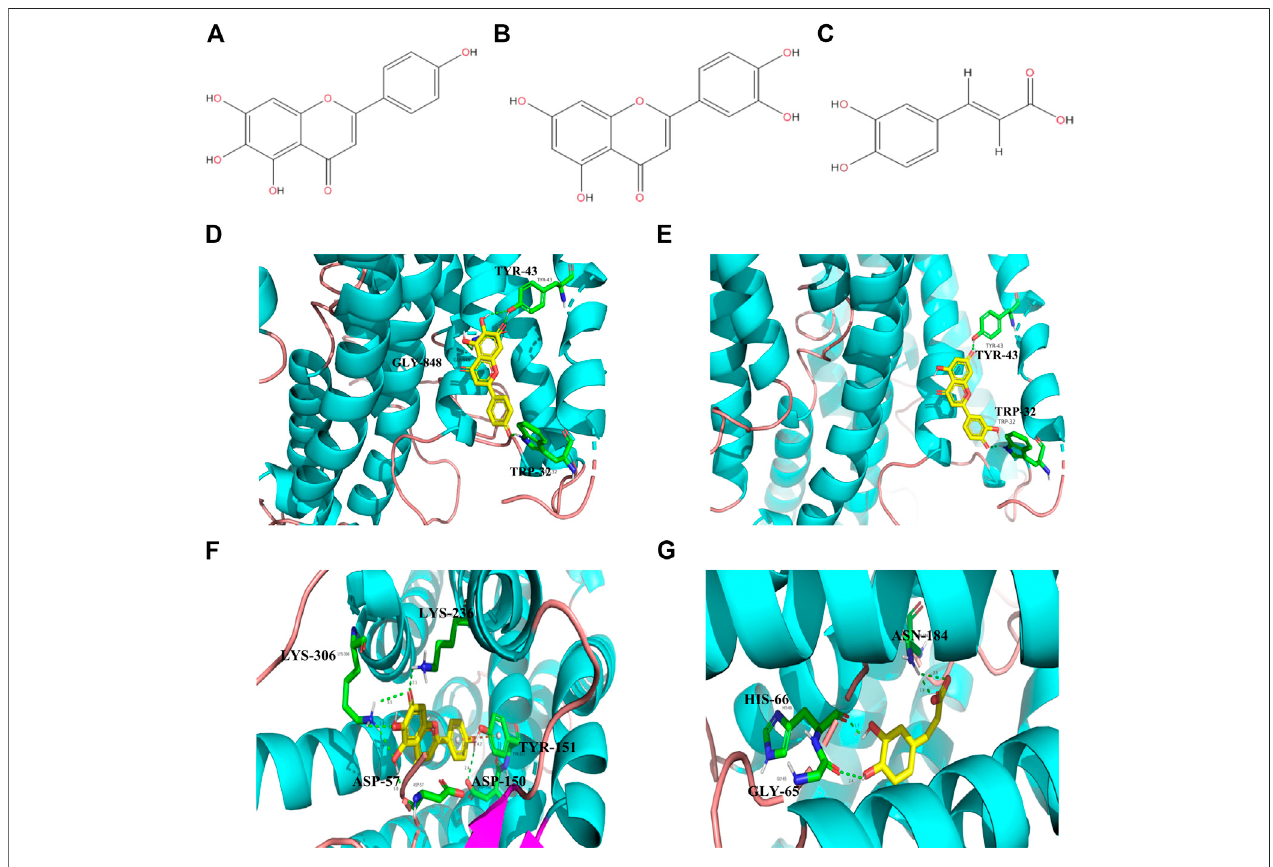
FIGURE 2 | Computer simulation of molecular docking. (A) The structure of scutellarein. (B) The structure of luteolin. (C) The structure of caffeic acid. (D) Scutellarein combines with Na + /K + -ATPase. (E) Luteolin combines with Na + /K + -ATPase. (F) Scutellarein combines with opioid receptor. (G) Caffeic acid combines with AQP4.